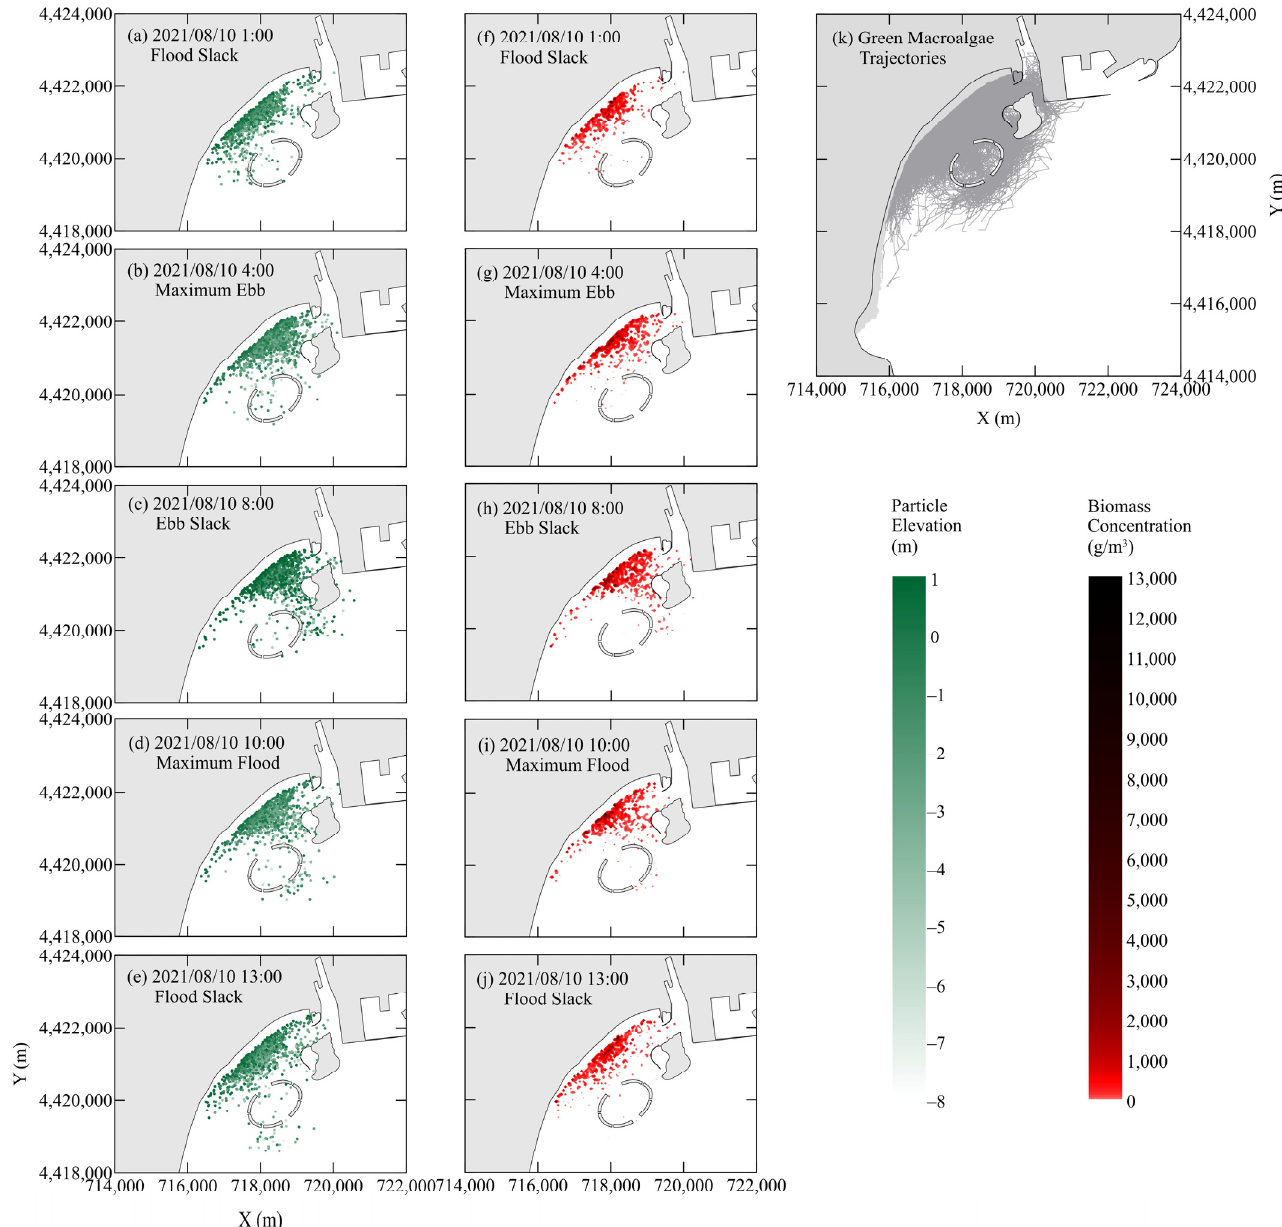
Figure 8. ( a – e ) Simulated distributions of the green macroalgae particles with colored elevations from 01:00 10 August 2021, to 13:00 10 August 2021; ( f – j ) Biomass concentration of the green macroalgae from 01:00 10 August 2021, to 13:00 10 August 2021; ( k ) Trajectories of the green macroalgae particles during the tide event in August 2021.